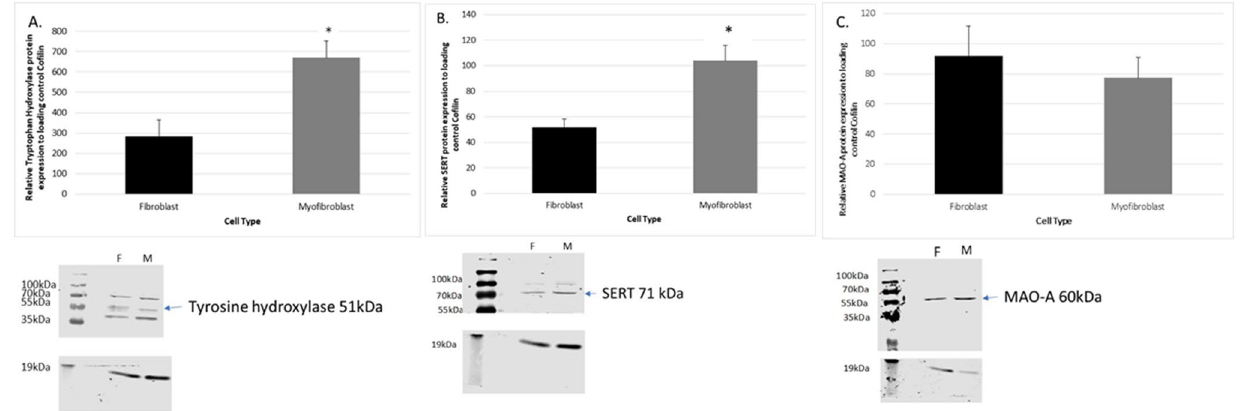
Figure 1. Expression of tryptophan hydroxylase (51 kDa) in isolated rat cardiac fibroblast and myofibroblast cells. Panel ( A ) represents the relative expression of tryptophan hydroxylase 1 in cardiac fibroblast and myofibroblast cells. Expression of SERT protein (71 kDa) in isolated rat cardiac fibroblast and myofibroblast cells. Panel ( B ) figure represents the relative expression of SERT in cardiac fibroblast and myofibroblast cells. Expression of MAO-A protein (60 kDa) in isolated rat cardiac fibroblast and myofibroblast cells. Panel ( C ) figure represents the relative expression of MAO-A in cardiac fibroblast and myofibroblast cells. Data represents the mean protein ± SEM (n = 5), * P < 0.05 versus fibroblast cell expression. Lower panel figure shows lanes 1 is the cardiac fibroblast samples (F) and 2 is the cardiac myofibroblast cell samples (M). Lower panel shows the loading standard cofilin (19